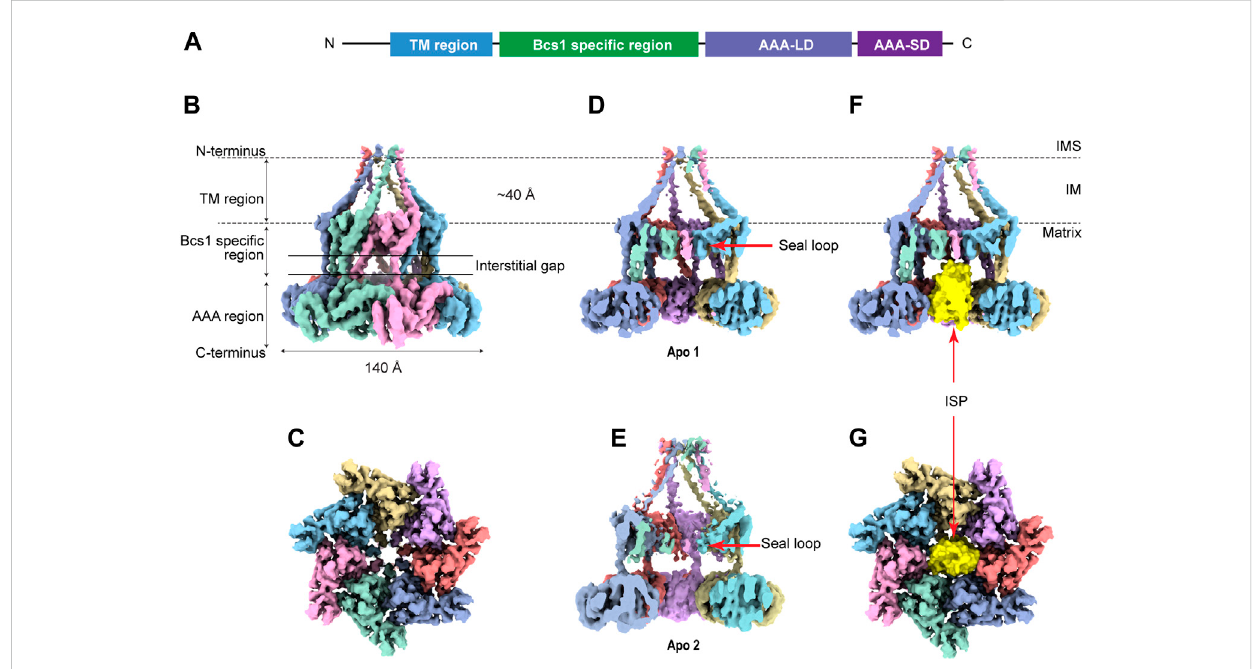
Overview of heptameric Bcs1 inApo state. (A) Schematicdiagram showing the domain organization of Bcs1. EMdensity map ofyeastBcs1 shown in sideview (B) andtopview (C) fromthematrixside. (D) CutsideviewofyBcs1inApo1statewithaconicalcavityinthemitochondrialinnermembraneand a cylindric cavity in the matrix. The two cavities are separated by the middle seal loops (EMD-10193). (E) Cut side view of yBcs1 in Apo 2 state where the middle seal loops were pointing towards the matrix thus connecting the two cavities (EMD-10194). The cylindric cavity in the matrix can accommodate a folded ISP-ED (shown in yellow), as is shown in cut side view (F) and top view (G)